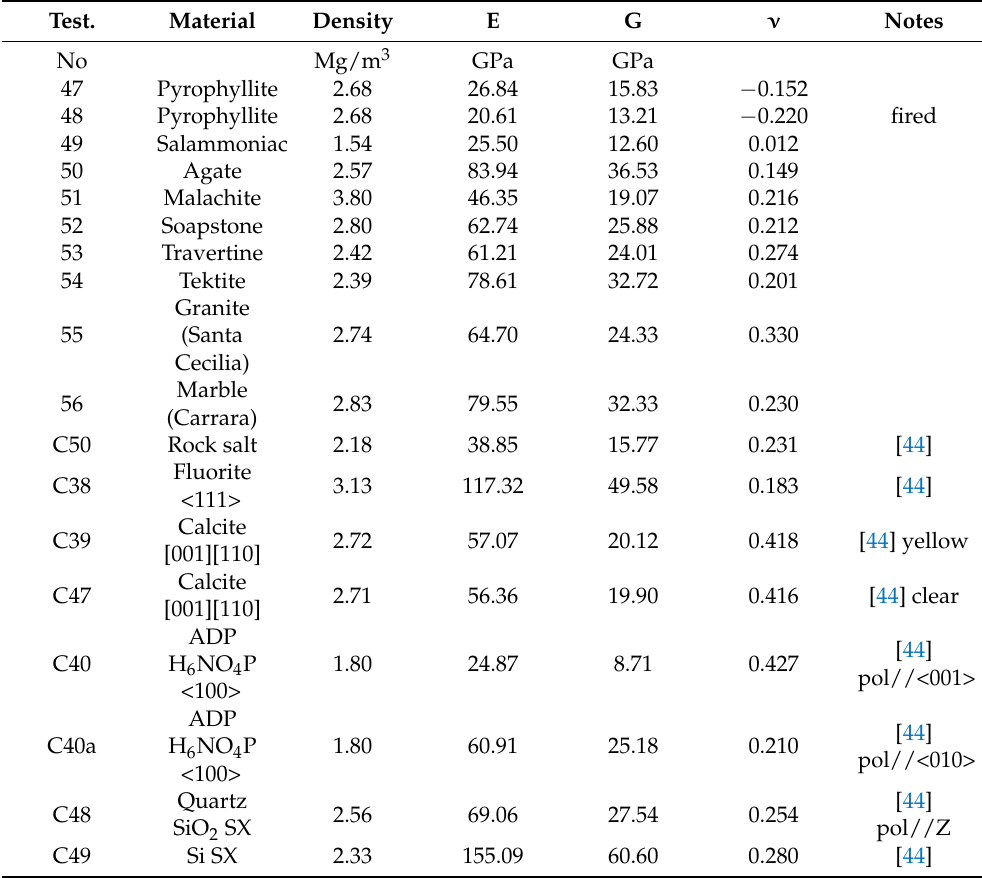
Table A3. Elastic constants of rocks and single crystals. Test.